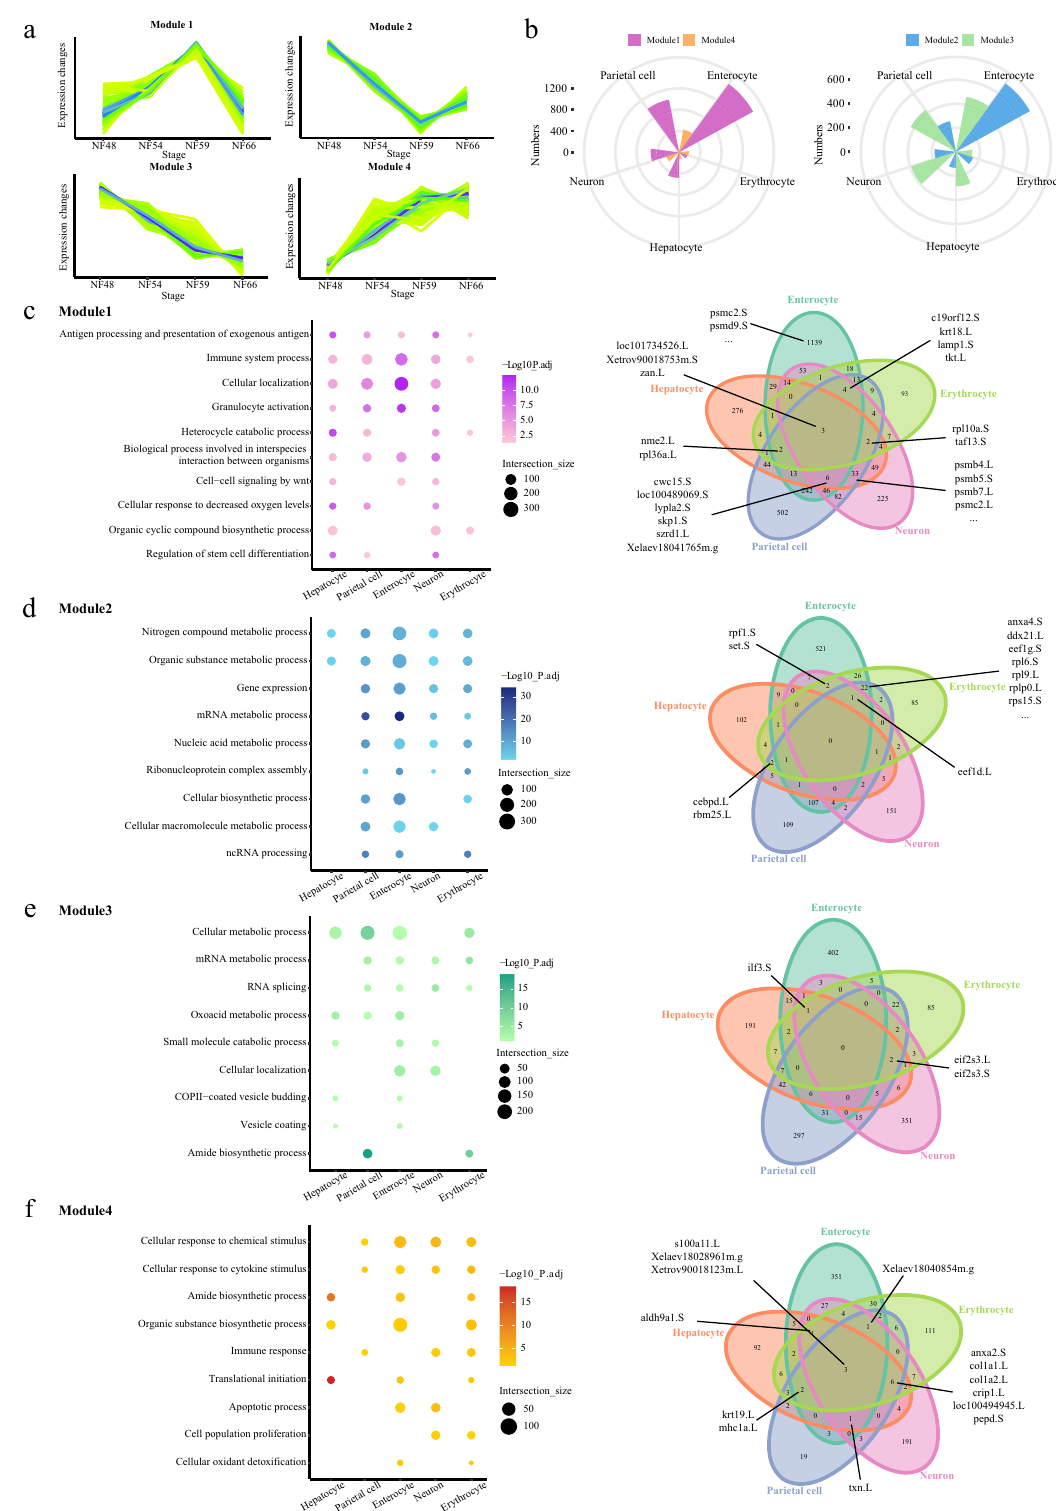
Fig. 6 Gene expression pro fi les of the remodeling multisystem during metamorphosis. a Schematic diagram of the four modules. b Rose diagrams showing the distribution of DEGs in each cell type. Different modules are labeled in different colors. c – f Representative GO terms enriched in module 1 ( c ), 2 ( d ), 3 ( e ), and 4 ( f ) for fi ve cell types, respectively (left). GO terms enriched in different modules are labeled in different colors. Venn diagrams showing the numbers of shared genes in each module (right). The bold lines indicate the representative genes shared in at least three cell types. P value was calculated by the hypergeometric distribution, statistical test is one-sided, adjustments P values were made after P value is corrected by Benjamin – Hochberg multiple